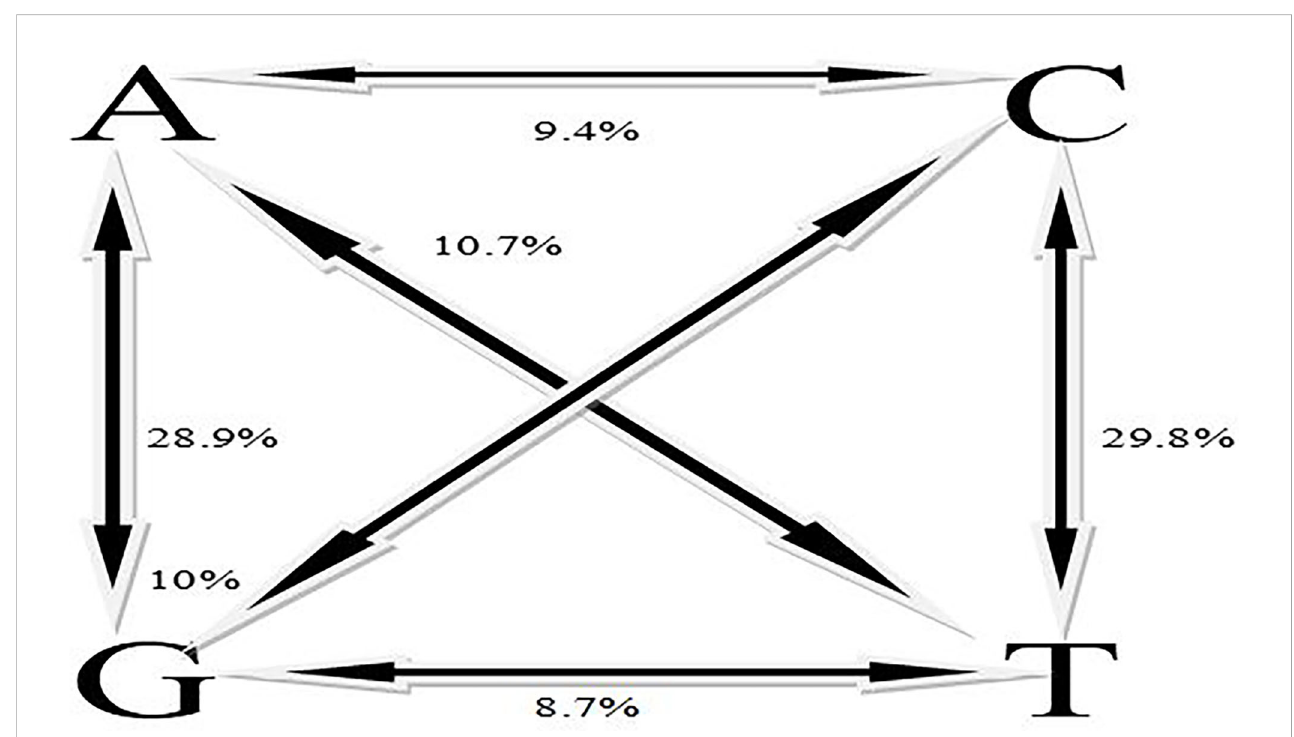
FIGURE 1 Percentage distribution of transitions and transversions among the SNPs.